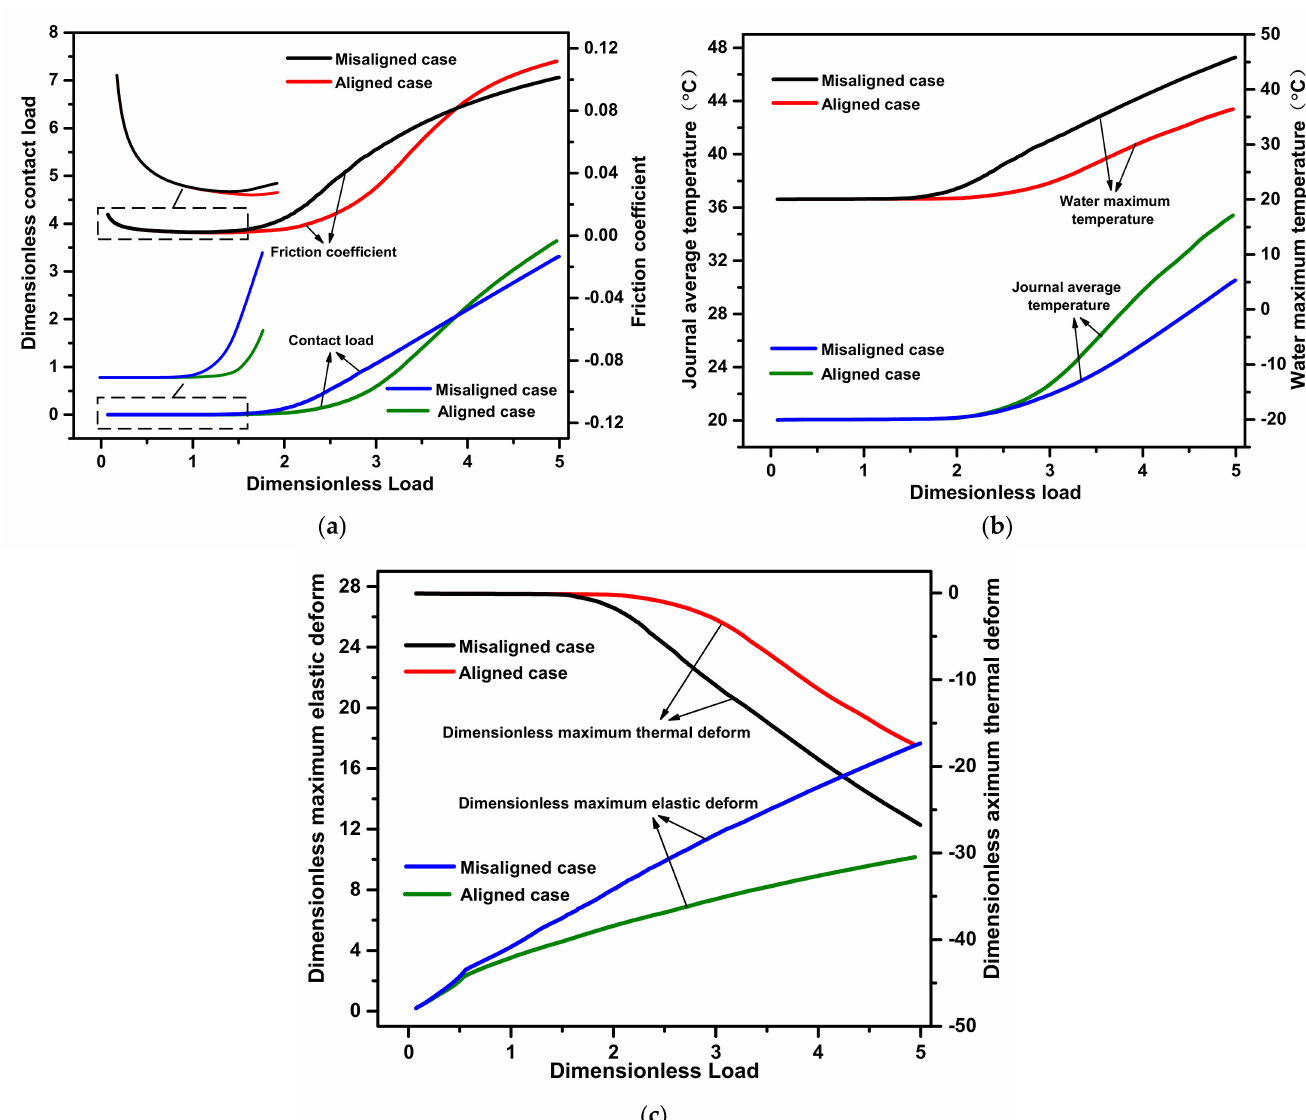
Figure 13. Comparisons of the FSH performance of the JWR system obtained with two cases of shaft, i.e., aligned shaft case and misaligned shaft case: ( a ) contact load and friction coefficient; ( b ) average temperature of journal and maximum temperature of water; ( c ) elastic and thermal